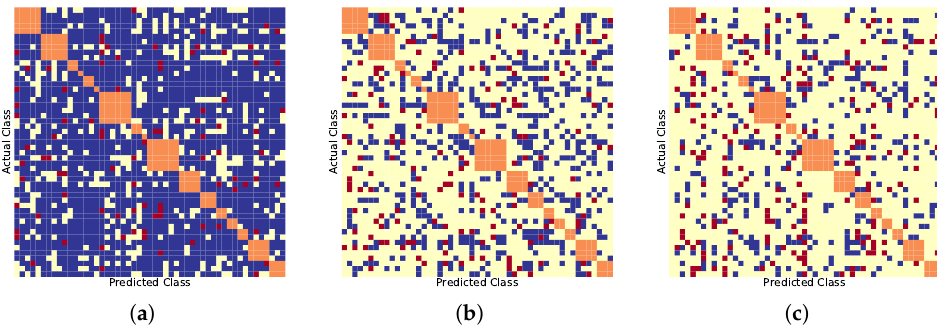
Figure 8. BDCM results on DVMM-51 using different model recogniser backbones. Blue, yellow, and red dots mark the positions filled in with 1,0, and − 1, respectively. Orange dots mark the different vehicle models that have the same make. ( a ) AlexNet [15] backbone, (#blue, #yellow, #red) = (1871, 442, 89). ( b ) ResNet50 [16] backbone, (#blue, #yellow, #red) = (575, 1674, 153). ( c ) DenseNet201 [17] backbone, (#blue, #yellow, #red) = (356, 1848, 198).